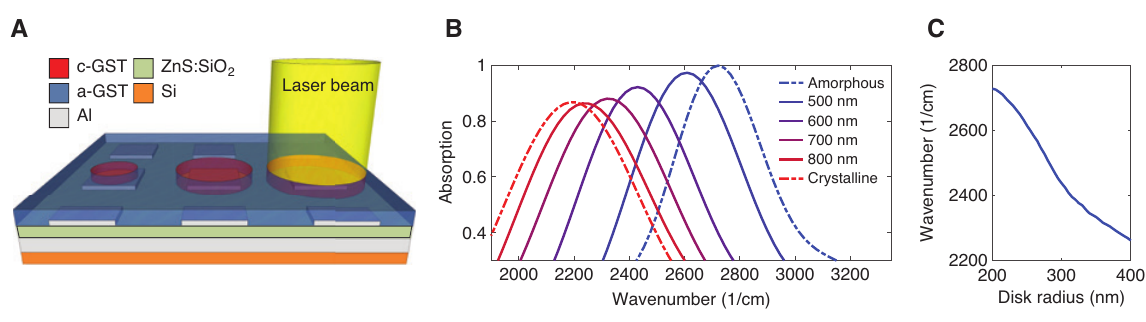
Figure 1: Switching scheme and idealized description of optical switching. (A) A sketch of the studied MS perfect absorber. Different illumination conditions lead to crystallized volumes of variable sizes. The superstrate layer is not shown for clarity. (B) Absorption spectrum of the perfect absorber for a completely amorphous (blue) and crystalline (red) GST layer (dashed-dotted lines) and for idealized cylindrical crystallized volumes with diameters of 500 nm, 600 nm, 700 nm and 800 nm. (C) Position of the absorption maximum as a function of the switched cylinder